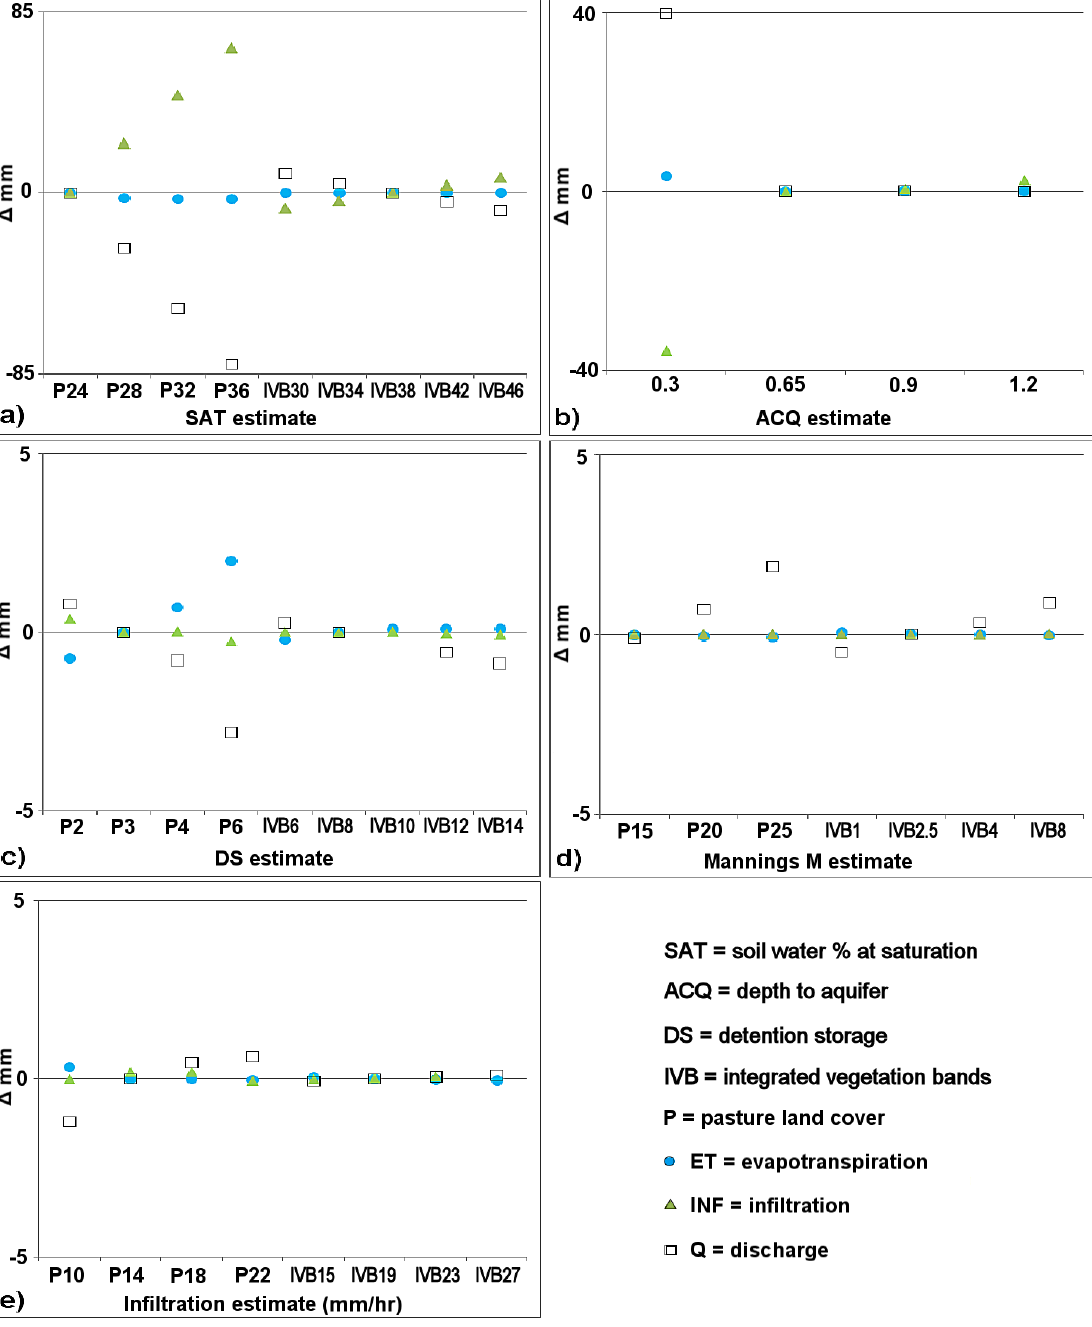
Figure 8. Scatter plots showing the difference (mm) between pasture and IVB simulation models in terms of evapotranspiration ( ET) , infiltration ( INF) and boundary outflow ( Q) water balance estimates. Five parameters had varying degrees of influence on water balance estimates, in order of significance these were: ( a ) soil water content at saturation ( SAT ); ( b ) depth to an impermeable layer ( ACQ ); ( c ) detention storage ( DS ); ( d ) surface roughness ( M ); and ( e ) infiltration rate ( K s